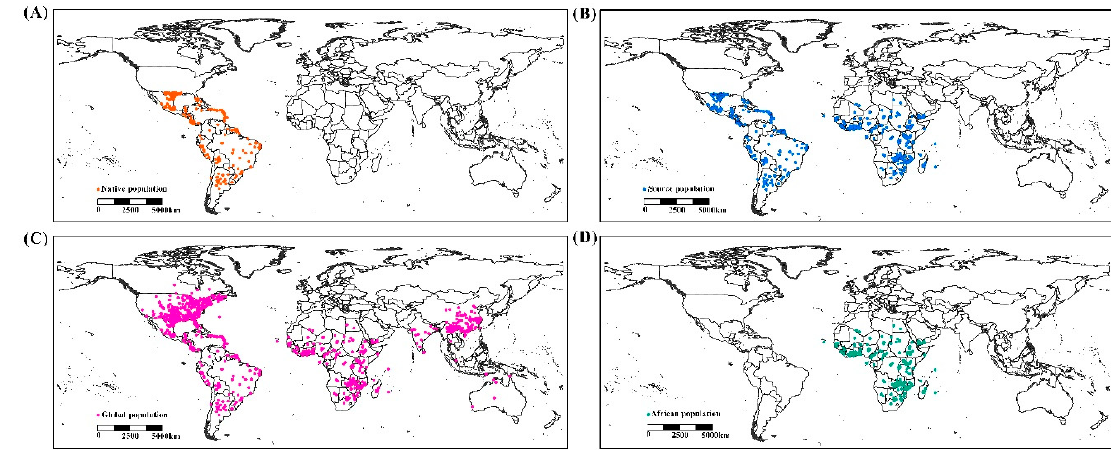
Figure 1. Geographic distribution records of Spodoptera frugiperda . ( A ) native population, ( B ) source population, ( C ) global population and ( D ) African population.